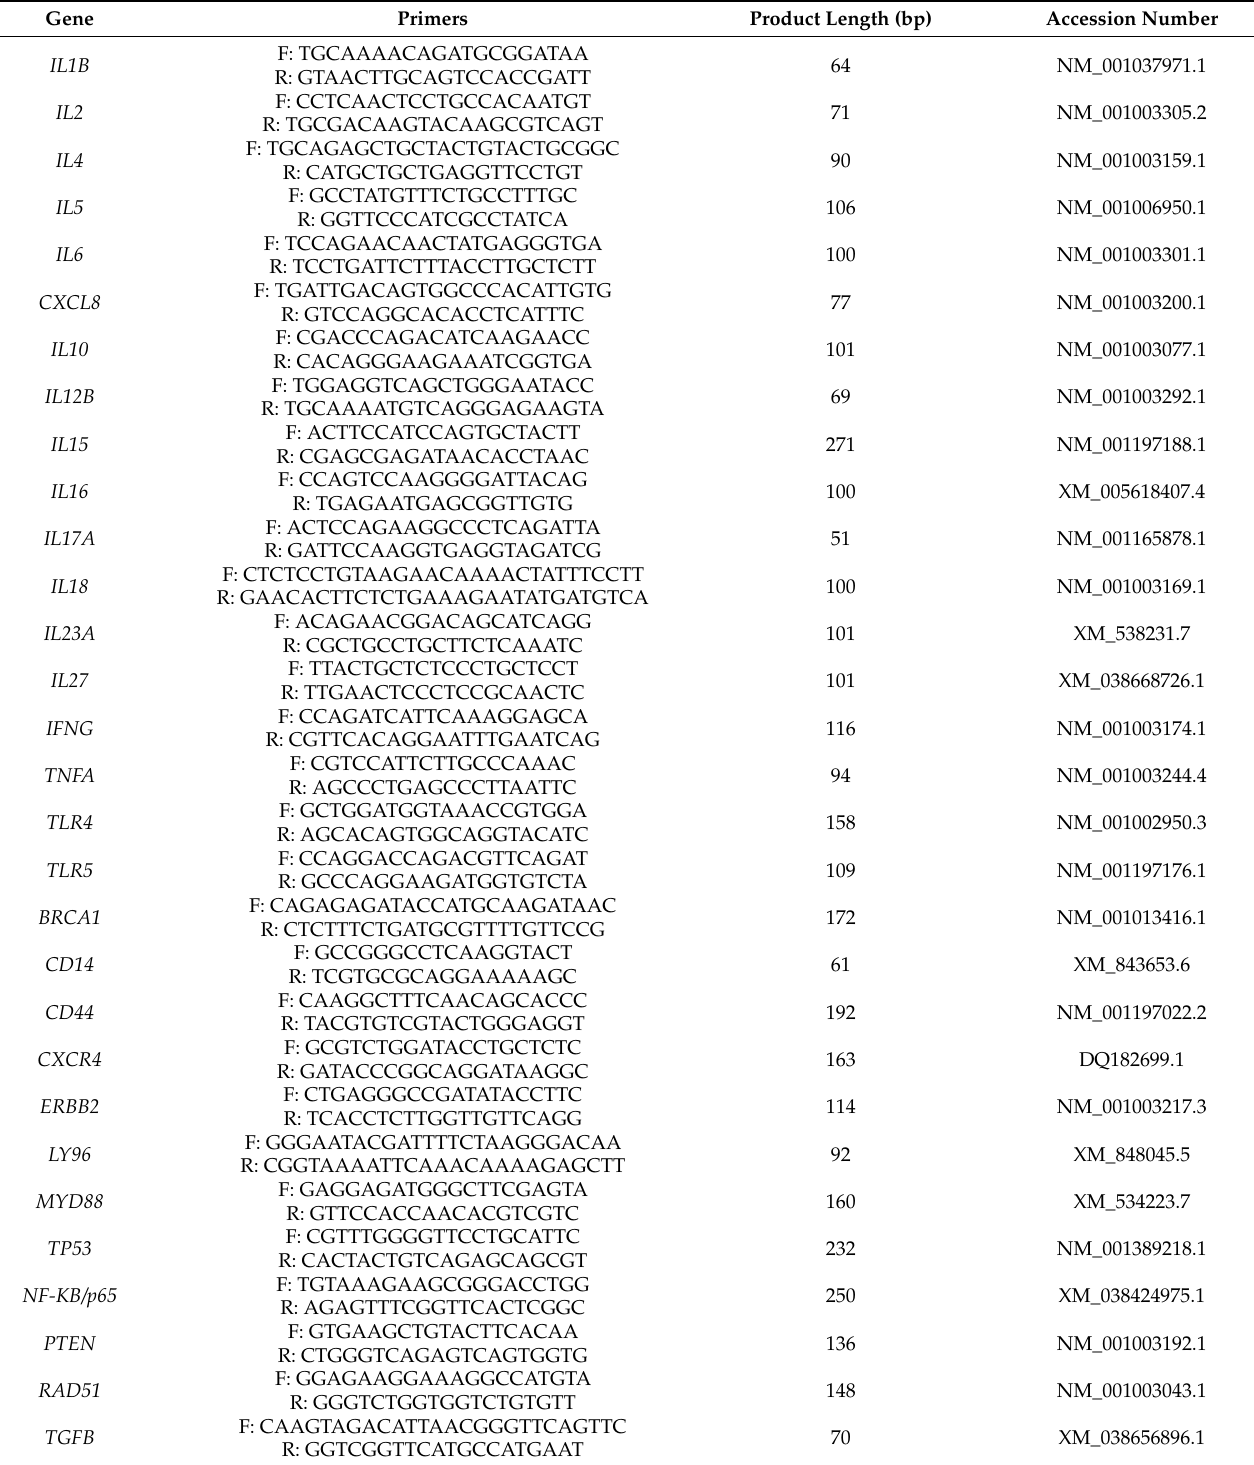
Table 2. Primer Sets for RT-qPCR evaluation of gene expression in